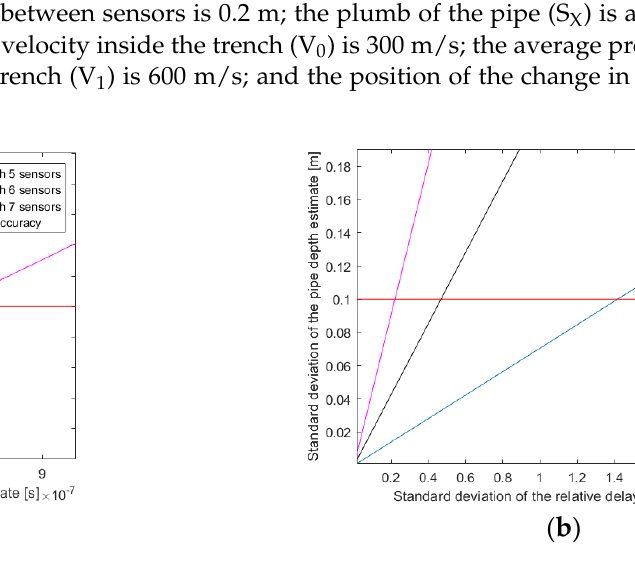
Figure 19. Depth error as a function of the error in the relative delay times: ( a ) for several numbers of sensors; ( b ) for several depths.